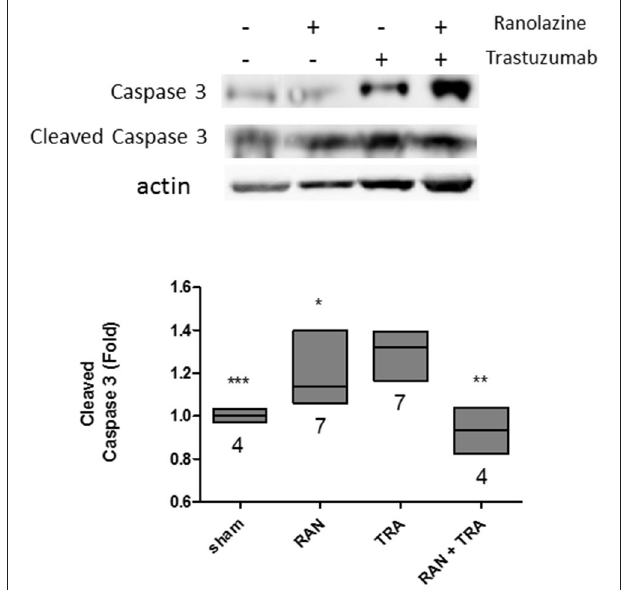
FIGURE 3 | Apoptotic pathway analysis in hearts of treated mice. Caspase 3 activation triggered by trastuzumab, was reduced by ranolazine treatment (* p < 0.05 vs. TRA; ** p < 0.005 vs. TRA; *** p < 0.0005 vs. TRA).